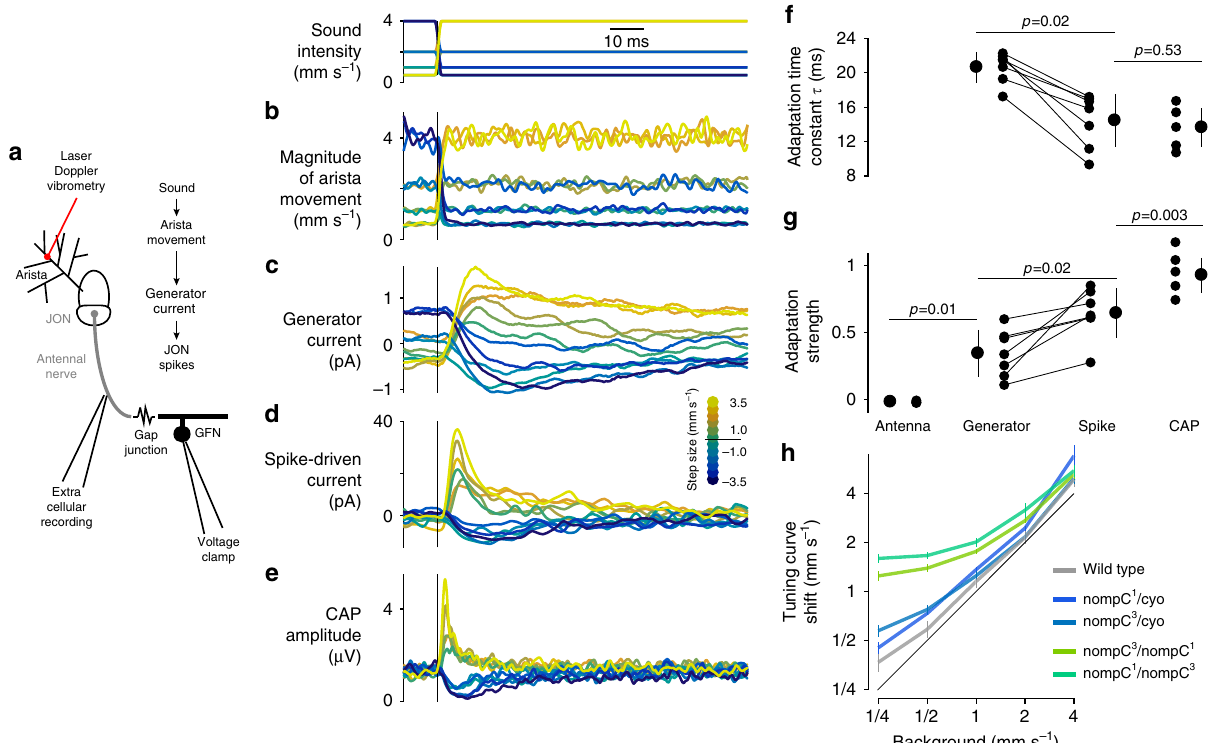
Fig. 4 Cellular basis of variance adaptation in JO neurons. a Sound-induced antennal movement was measured using laser vibrometry ( b ). Generator ( c ) and spike-driven ( d ) currents were read out via patch clamp recordings of the giant fi ber neuron (GFN), after bath application of TTX ( c ) or with normal saline ( d ). b – e Amplitude pro fi le of the noise steps used to probe adaptation in different processing stages in JONs (top). Step size is color coded (see legend in d ). Magnitude of antennal movement ( b ), generator current ( c ), spike-driven currents ( d ), and CAP ( e ) to the intensity steps. Adaptation transients fi rst arise in the generator current ( c ). All panels show one fl y with 20 trials per step ( c — 100 trials per step). f Time constant of adaptation at different stages within JON processing obtained by fi tting exponentials to the transients in b – e (time constant averaged across all step sizes). The lack of adaptation in the antennal movements prevented estimation of time constants for the antenna. P values indicate the results of two-tailed tests (sign test for paired data (generator vs. spike), rank sum for unpaired data (LDV (laser Doppler vibrometry) vs. generator, spike vs. CAP)). N = 7 fl ies for generator/spike, N = 4 for LDV, N = 5 for CAP (number of trials as in b – e ). g Strength of adaptation for the signals in b – e was obtained by comparing the responses to the different intensities at step onset vs. steady state. Adaptation values of 1.0 indicate complete adaptation (values can be greater than 1 or smaller than 0 due to noise in the CAP responses). Statistical procedures and N as in f . Error bars in f and g show mean ± standard deviation over fl ies. h Adaptation in fl ies mutant for the TRP channel nompC (green, blue, wild-type fl ies shown in gray for comparison). All mutants adapt for background intensity by shifting their tuning curve. The black diagonal line corresponds to perfect adaptation, complete absence of adaptation would lead to horizontal trends. Adaptation is reduced for soft backgrounds (1/4 – 1mms − 1 ) in the nompC double mutants due to their reduced sound sensitivity. Mean ± s.d. over fl ies (see Supplementary Fig. 9 for N